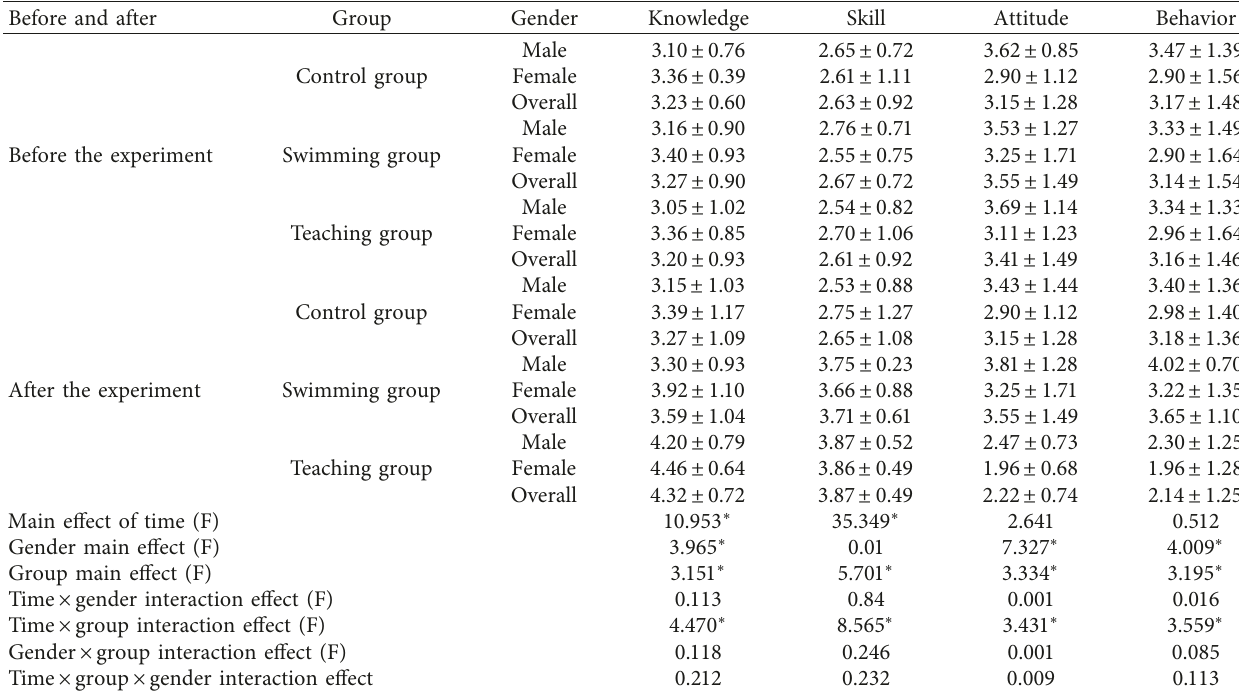
Table 1: The test results of descriptive statistics and repeated measures analysis of variance before and after the integration of water safety education for primary school students with swimming teaching. Before and after